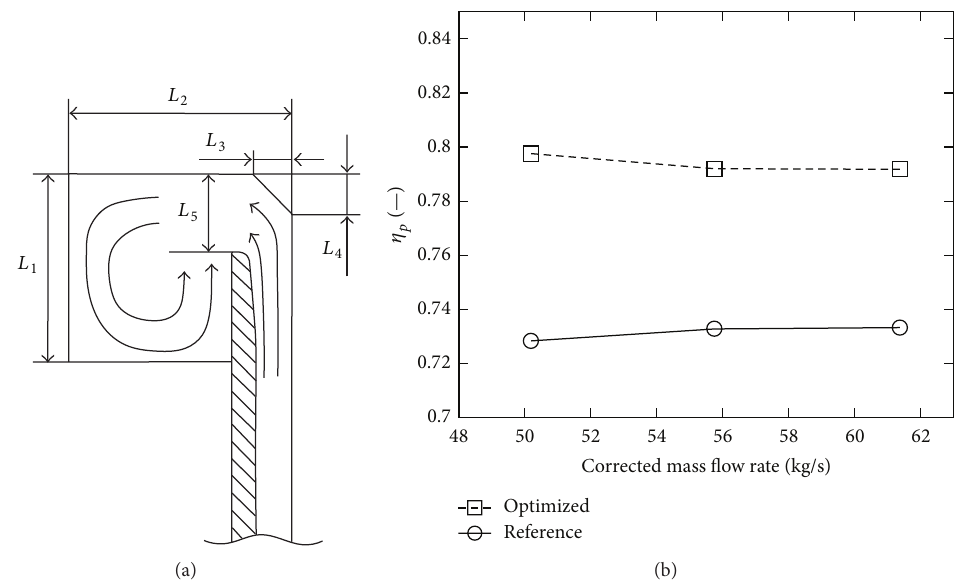
Figure 3: Five geometric parameters of volute shape (a) and polytropic efficiency 𝜂 𝑝 of the reference and optimized volute geometry (b) as a function of the mass flow rate ̇𝑚 corr according to Huang et al. [15].